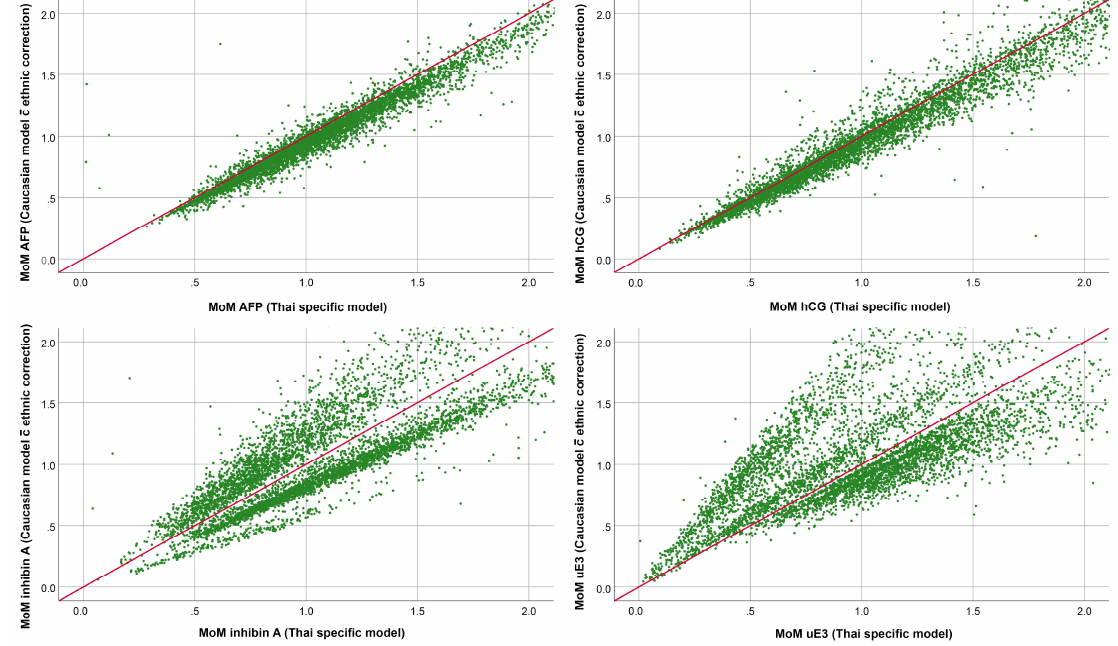
Figure 2. The relationship between the MoMs for AFP, beta-hCG, inhibin-A and uE3, using the Thai model in this study on the X-axis and the Caucasian model with ethnic correction on the Y-axis. The line represents the line of equity or expected MoMs. Table 2. Comparisons of MoMs derived from Caucasian and Thai references (Wilcoxon signed-rank test). Serum Markers